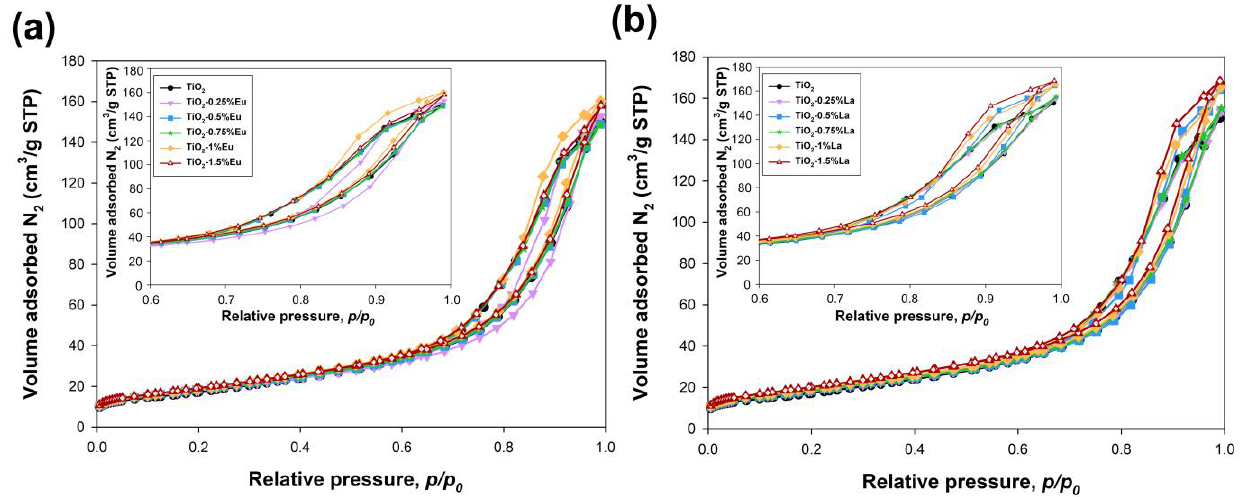
Figure 8. Nitrogen adsorption-desorption isotherms for the synthesized ( a ) TiO 2 -Eu and ( b ) TiO 2 -La systems.